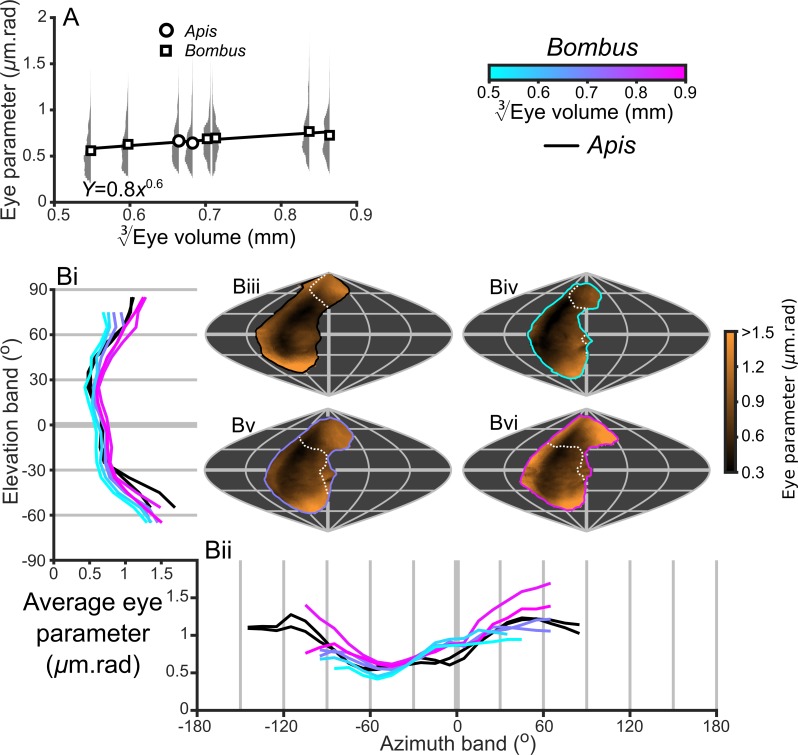
Description of the local eye parameter of compound eyes.(A) The average eye parameters and relative distribution for each bee vs. 3EV. The plotted curve results from fitting the function parameters to the measurements for Bombus (additional details in Supplementary file 1–Table S1). (B) The topographic distribution of eye parameter (indicated by the orange color bar) projected from each bee into the visual world, shown as sinusoidal projections for a honeybee (iii), and for small- (iv), medium- (v) and large- sized (vi) bumblebees (azimuth and elevation lines are plotted at 60° and 30° intervals, respectively). Profiles of average eye parameter are shown for elevation (panel Bi, eye parameter is averaged across all azimuth points in each eye’s CP as function of elevation) and azimuth (panel Bii, eye parameter is averaged across all elevation points in each eye’s CP as a function of azimuth). The white dotted lines across the topology in Biii to Bvi indicate the border of the bee’s corneal binocular CP. The cyan-to-magenta color bar indicates the EV3 of Bombus for each curve in all panels, whereas black lines indicate honeybees. Note that we used the calculated IF angle (Figure 3B) in place of the IO angle when calculating the eye parameter.